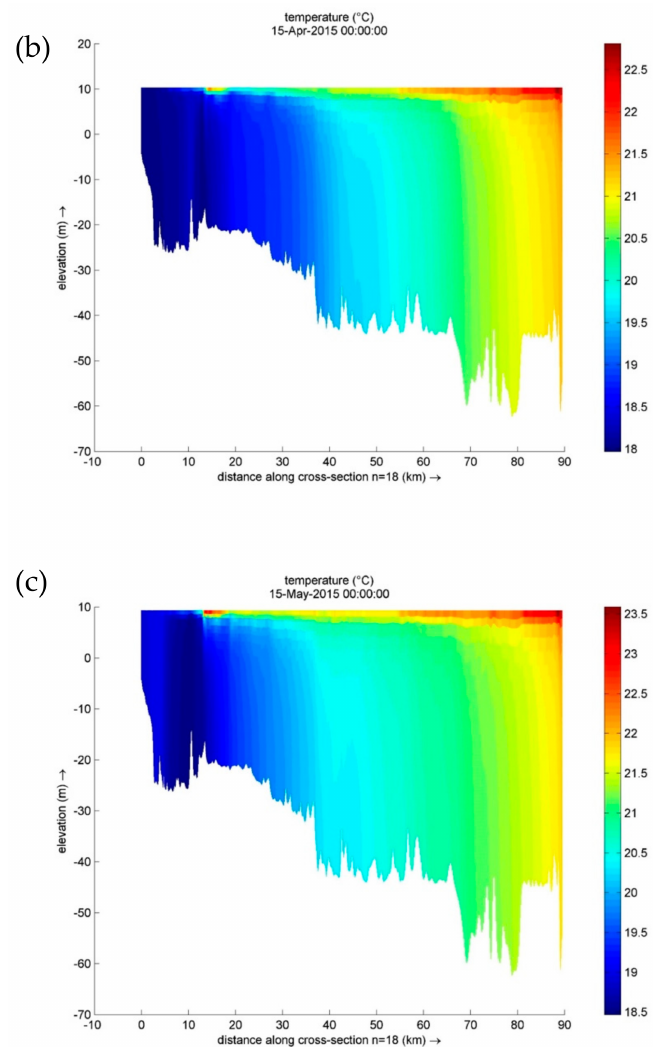
Figure 9. Simulated water temperature profile along the reservoir on ( a ) 15th March, ( b ) 15th April, and ( c ) 15th May of